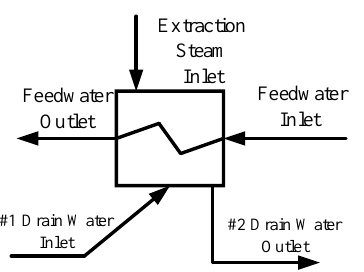
Figure 1. Structure of FWH.